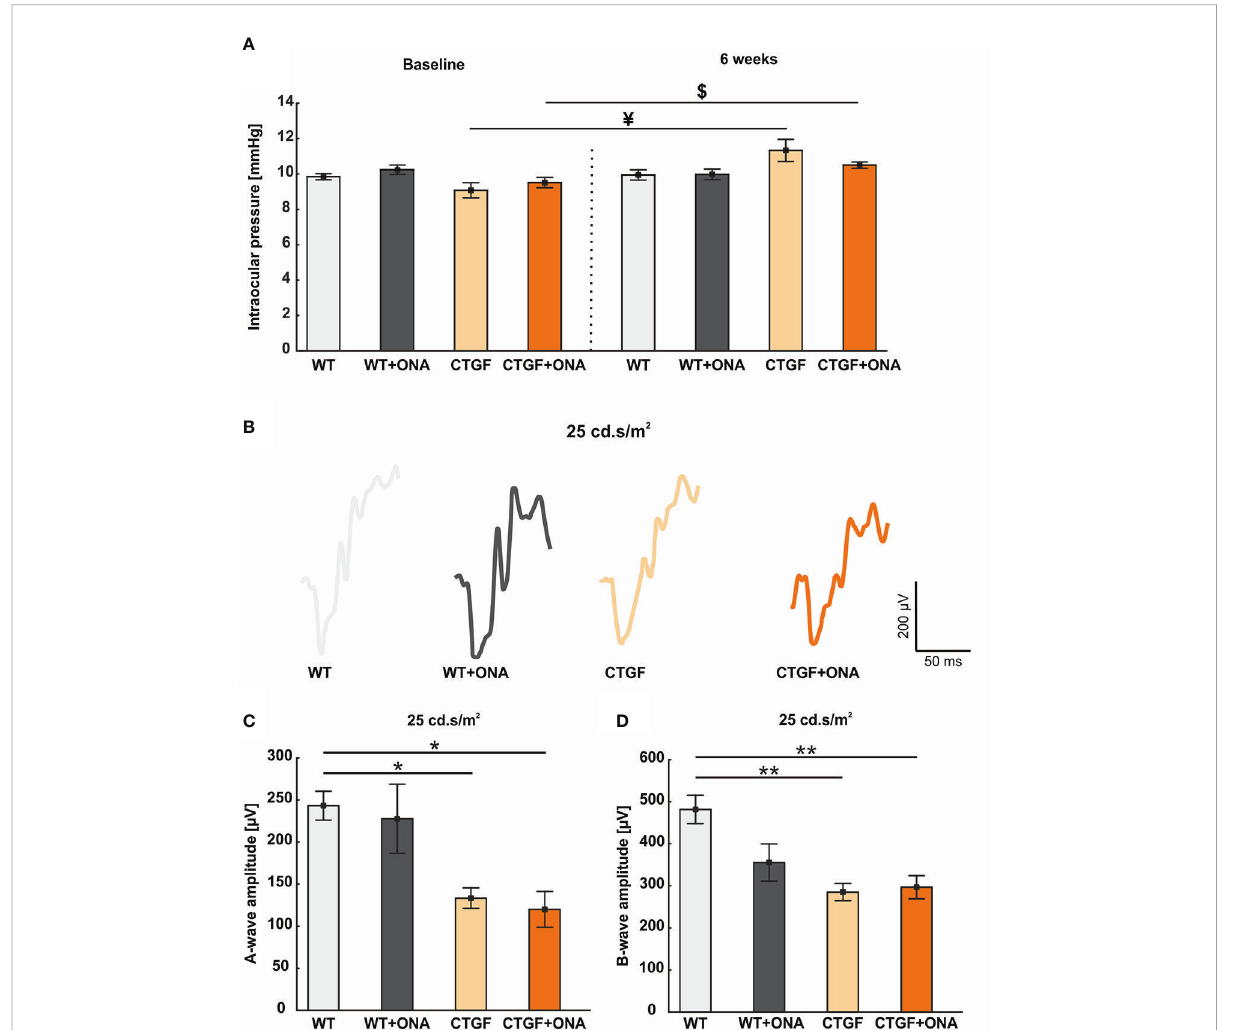
FIGURE 1 Mild increase of IOP and loss of retinal function. (A) The IOP measurements before (baseline) and six weeks after immunization are displayed. At baseline, the IOP was comparable in all groups. Also, no changes could be observed six weeks after immunization between the